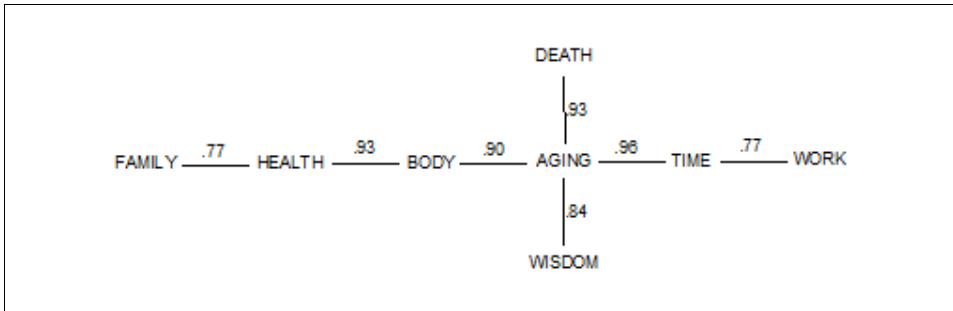
Figure 1 . Maximum similarity tree from direct rated distances among the social